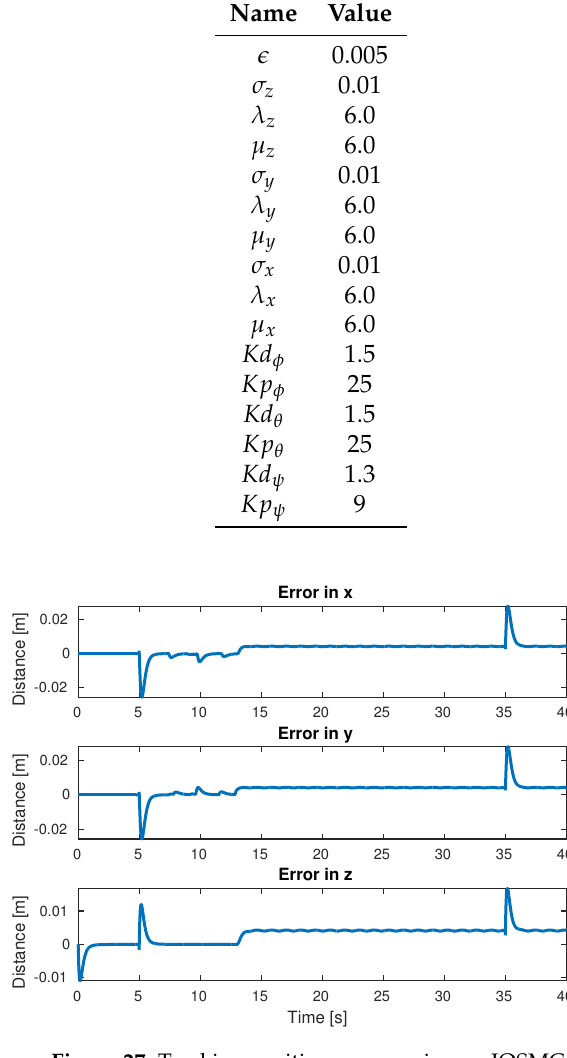
Figure 27. Tracking position errors using an IOSMC.